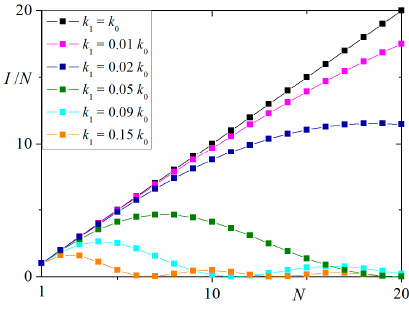
Figure 6. Scaling of diffraction intensities plotted vs . coherence length (number of atoms in the chain). The significant deviation from N 2 clearly seen even for small values k 1 relative to k 0 = 2 π .